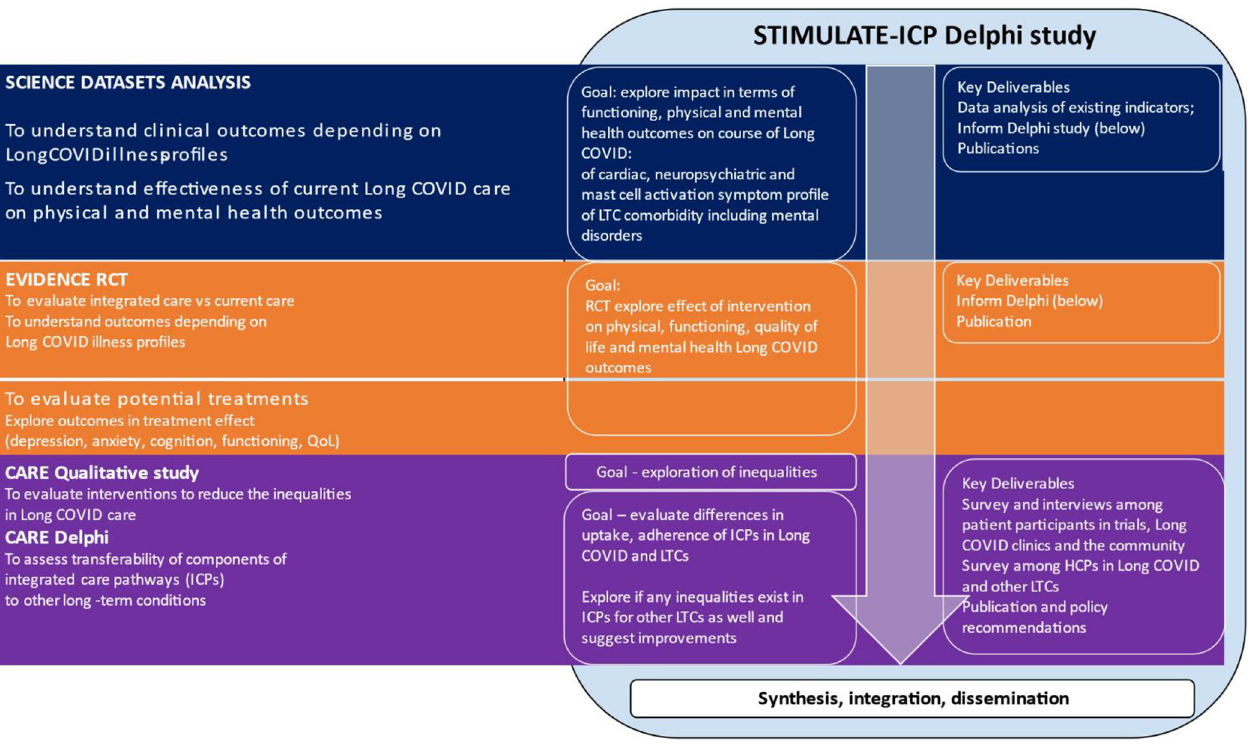
PLOS ONE | https://doi.org/10.1371/journal.pone.0277936 November30,